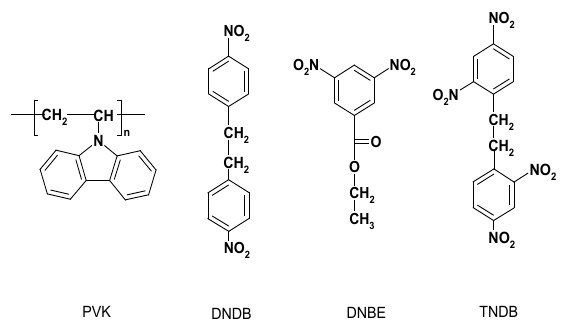
Figure 1. Chemical structures of PVK and electron